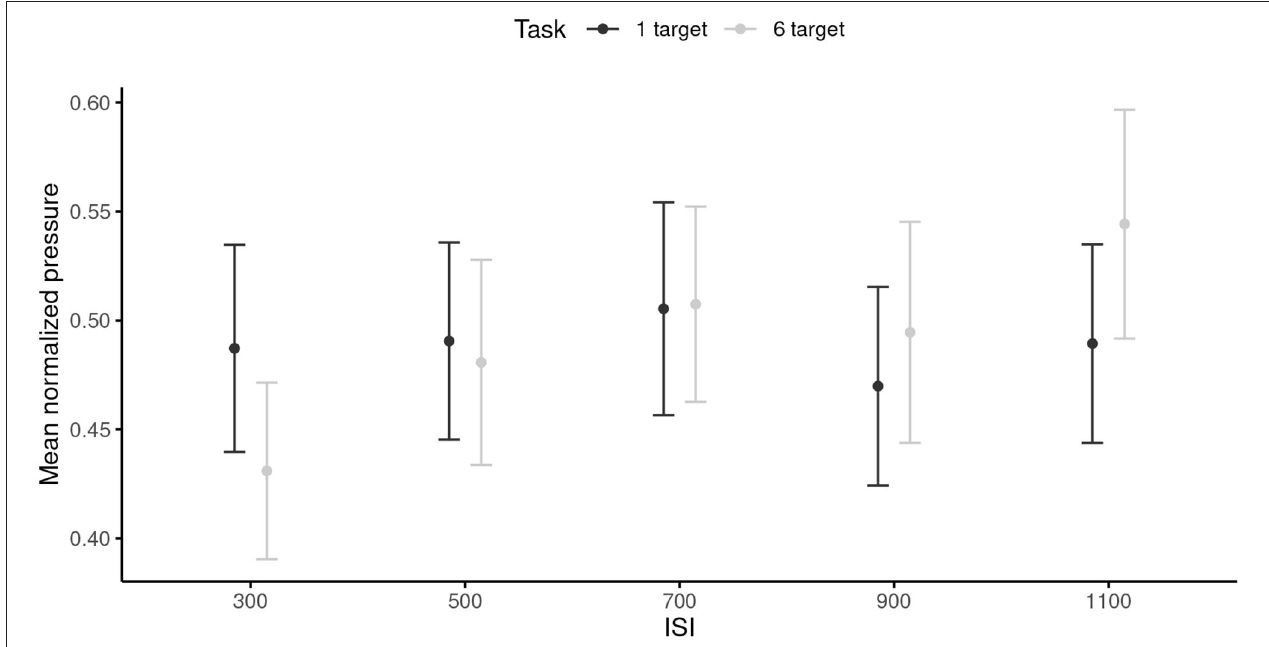
FIGURE 3 | Mean pressure for each inter-stimuli interval, and each task. 95% are represented in the figure by the error bars attached to each mean point. ISI, inter-stimuli interval.